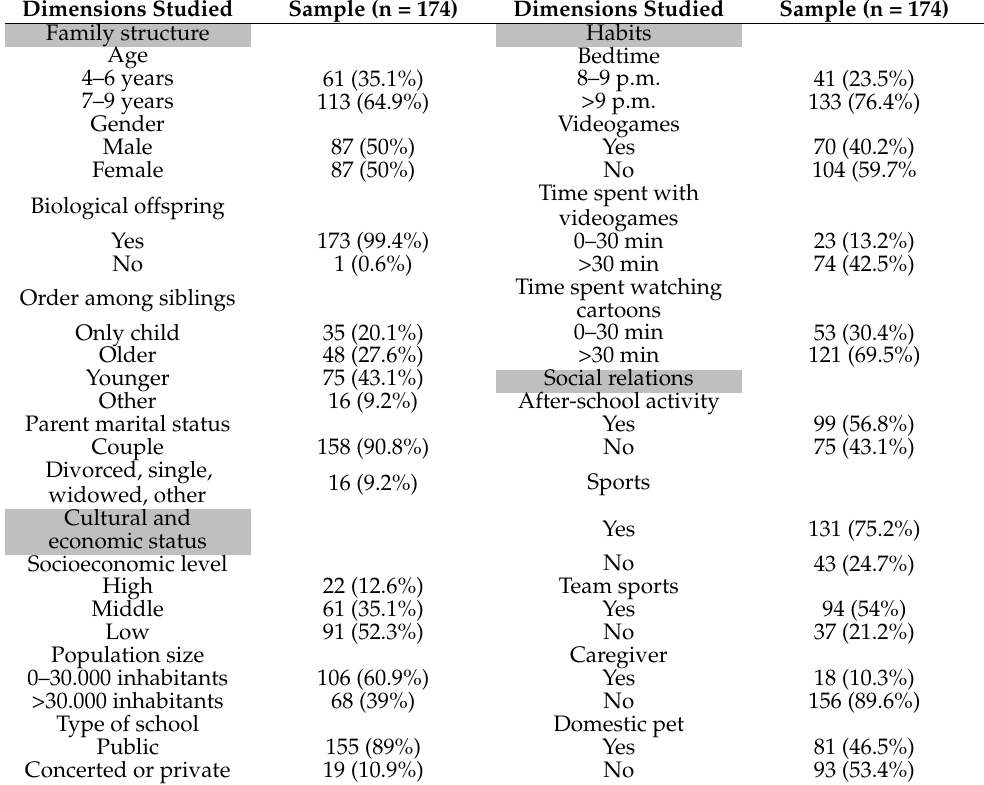
Table 2. Frequencies of the variables of the questionnaire administered to the